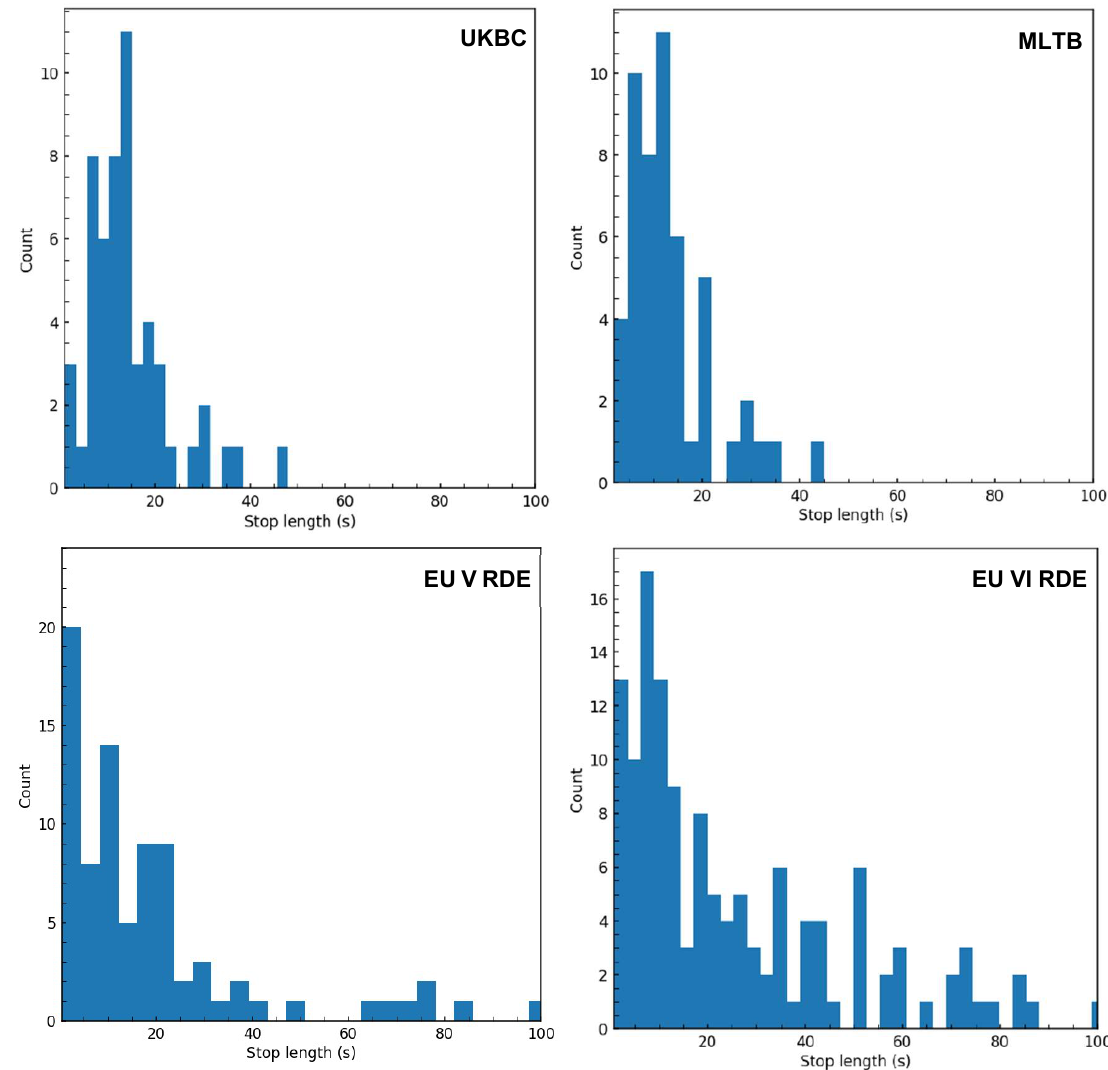
Figure 19. Comparison in stop lengths between UKBC, MLTB, Euro V, and Euro VI bus RDE.